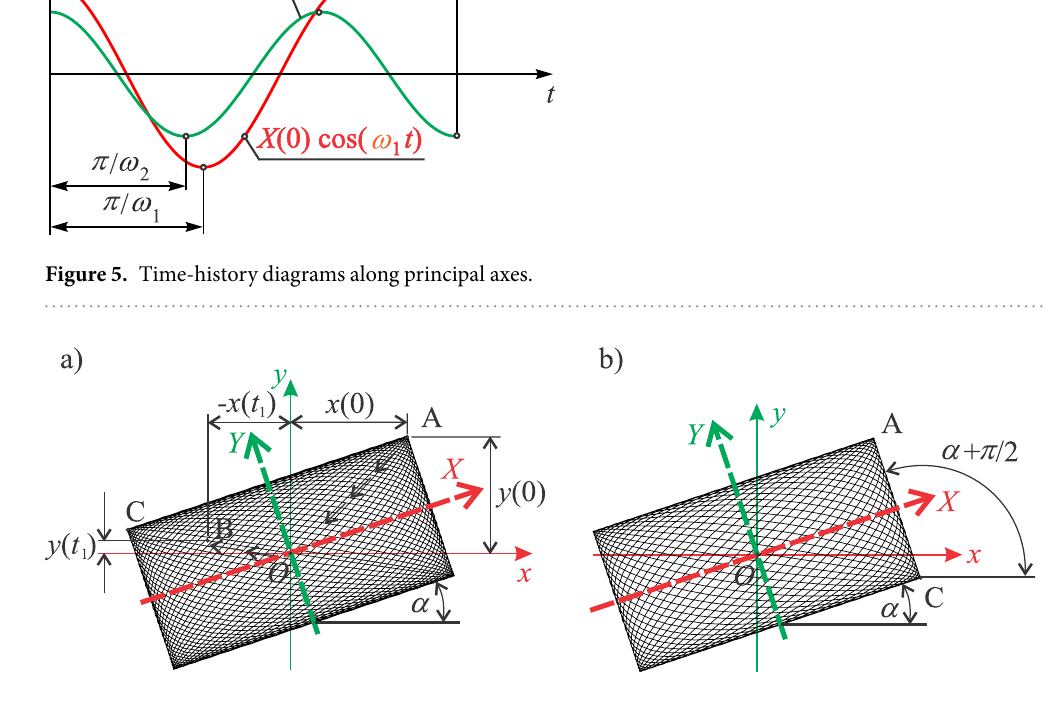
Figure 6. ( a ) Motion of the particle with respect to the characteristic rectangle; ( b ) The case when C is in the right lower